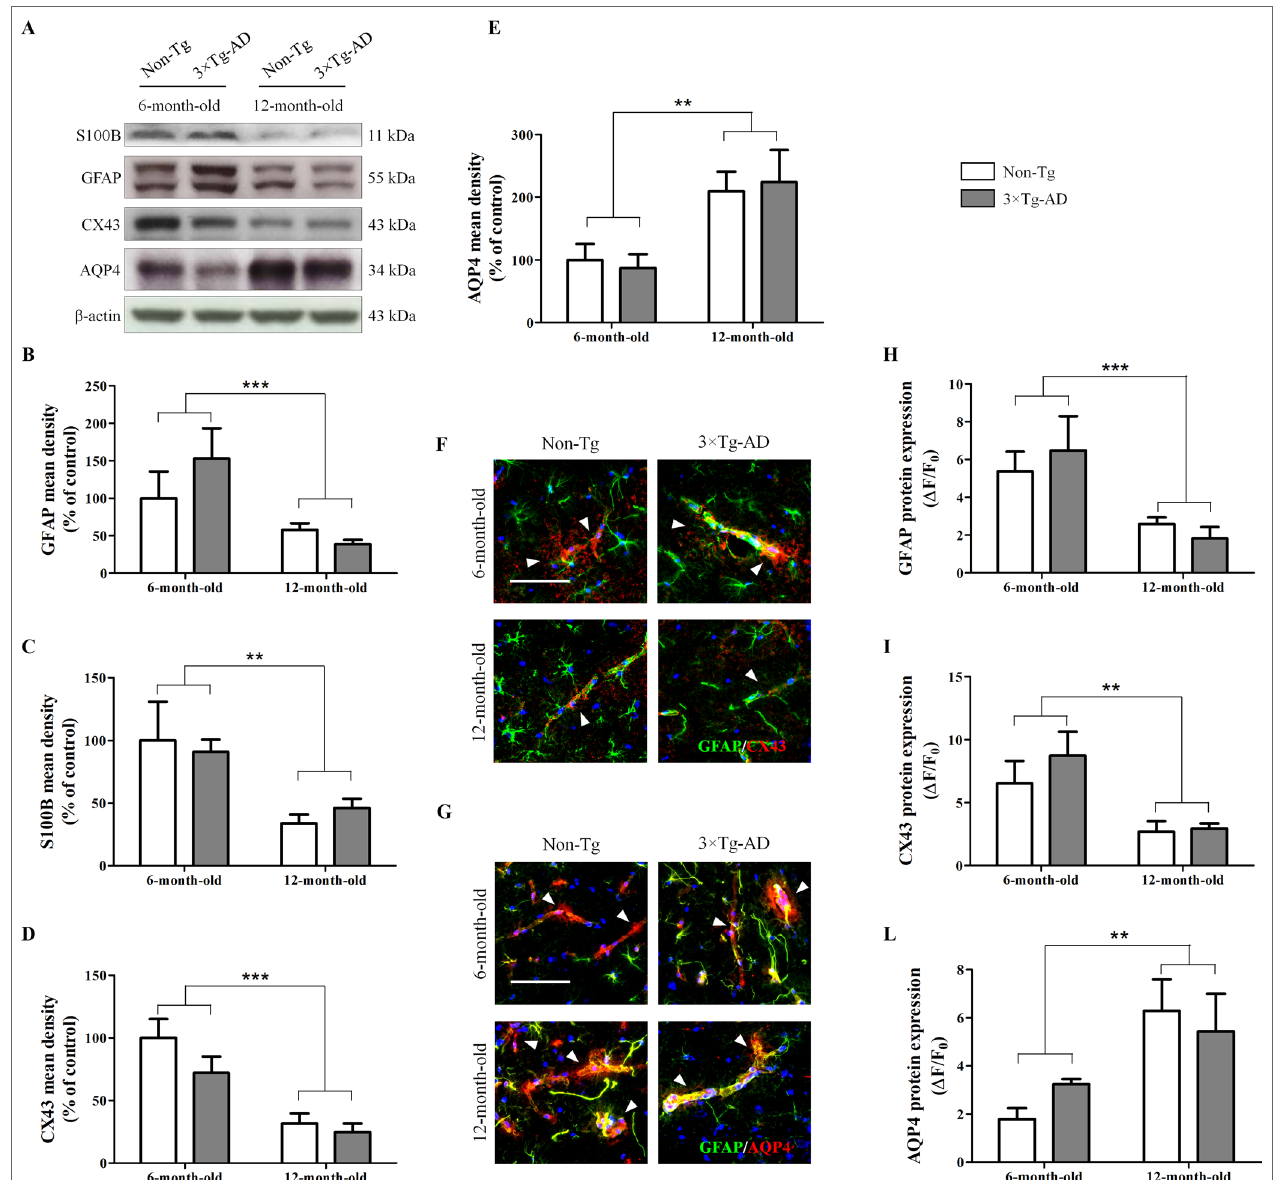
FIGURE 1 | Effects of aging on morphology and functions of hippocampal astrocytes. (A) Representative western blots for GFAP, S100B, CX43 and AQP4 and (B , C , D , E) densitometric analyses normalized to β -actin loading control. Results are expressed as means ± SEM of percentage of controls (6-month-old/Non-Tg) (N = 3, in triplicate). (F) Representative fluorescent photomicrographs of CX43 (red) and GFAP (green) in the hippocampal CA1 region of both 6- and 12-month-old Non-Tg and 3×Tg-AD mice. White arrows indicate CX43 mainly expressed in astrocytes enveloping blood vessels. (G) Representative fluorescent photomicrographs of AQP4 (red) and GFAP (green) in the hippocampal CA1 region of both 6- and 12-month-old Non-Tg and 3×Tg-AD mice. White arrows indicate AQP4 expressed in astrocyte end-feet surrounding blood vessels. Fluorescence analyses of (H) GFAP, (I) CX43 and (L) AQP4 are expressed as ΔF/F 0 = [(F− F 0 )/F 0 ], where F is the mean fluorescence intensity and F 0 is the mean background fluorescence. Nuclei were stained with DAPI (blue). Scale bar 50 µm. Statistical analysis was performed by two-way ANOVA followed by Bonferroni’s post hoc test (** p < 0.01; *** p < 0.001, 6-month-old vs